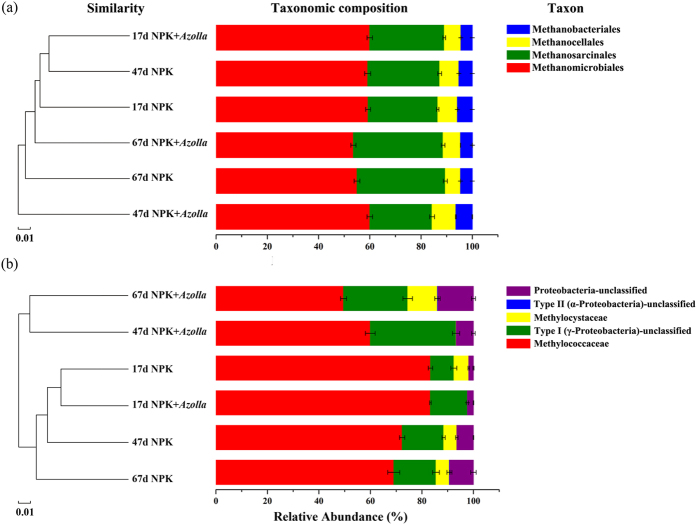
Cluster analysis (left) combined with taxonomic composition barplot (right) of methanogenic archaea (a) and methanotrophic bacteria (b). NPK, rice cropping without dual cropping of Azolla under recommended fertilization; NPK + Azolla, rice cropping with dual cropping of Azolla under recommended fertilization.